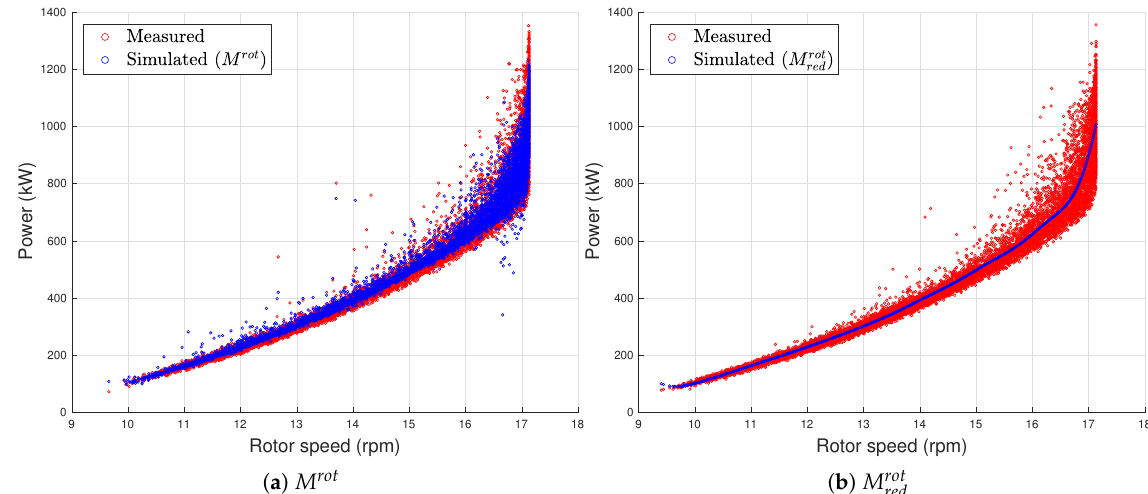
Figure 10. Measured and simulated rotor speed-power curves: D2 data set, T1 wind turbine. M rot model on the left, M rot on the right.